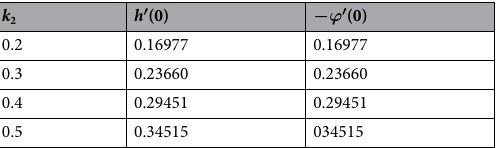
Table 5. Numerical values of h ′ (0) and − ϕ ′ (0) for different values of k 2 when δ = 1.